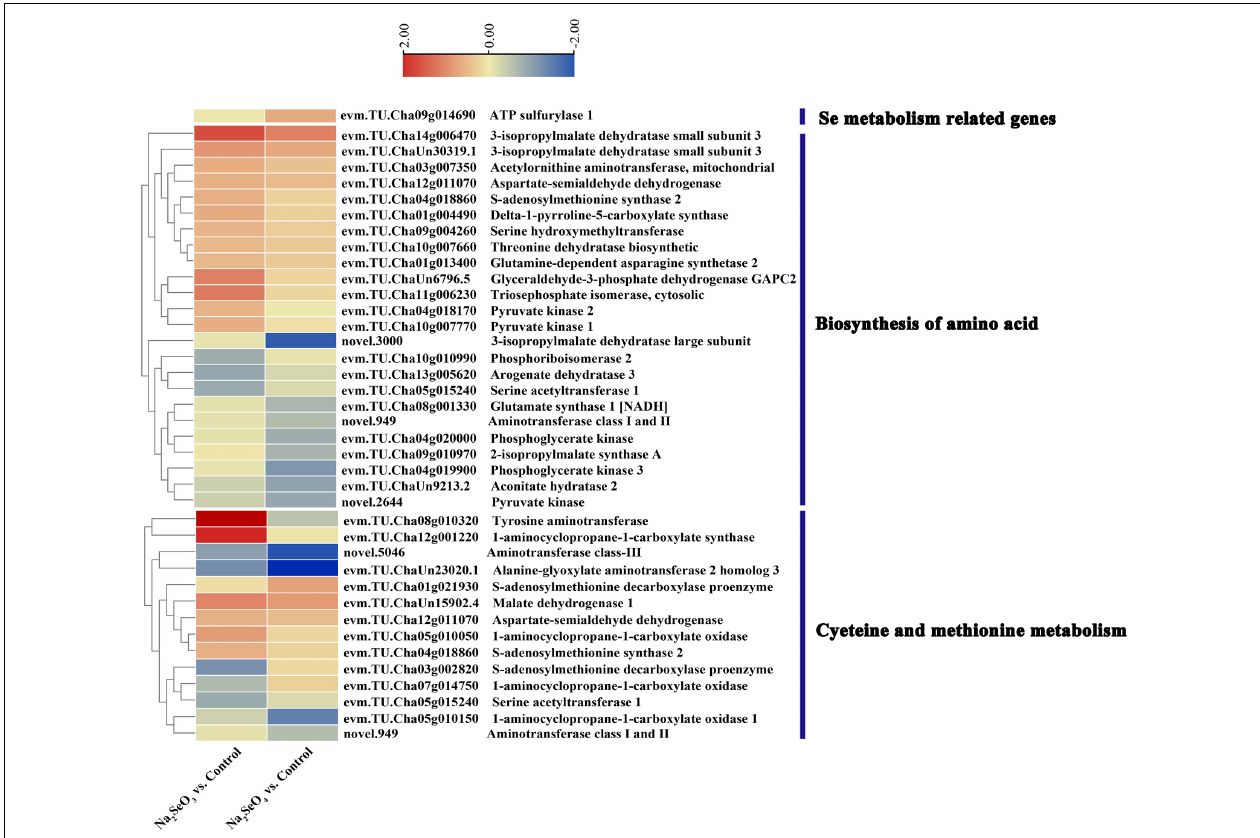
FIGURE 5 | Heatmap of DEGs related to selenium and amino acid metabolism in response to selenite and selenate